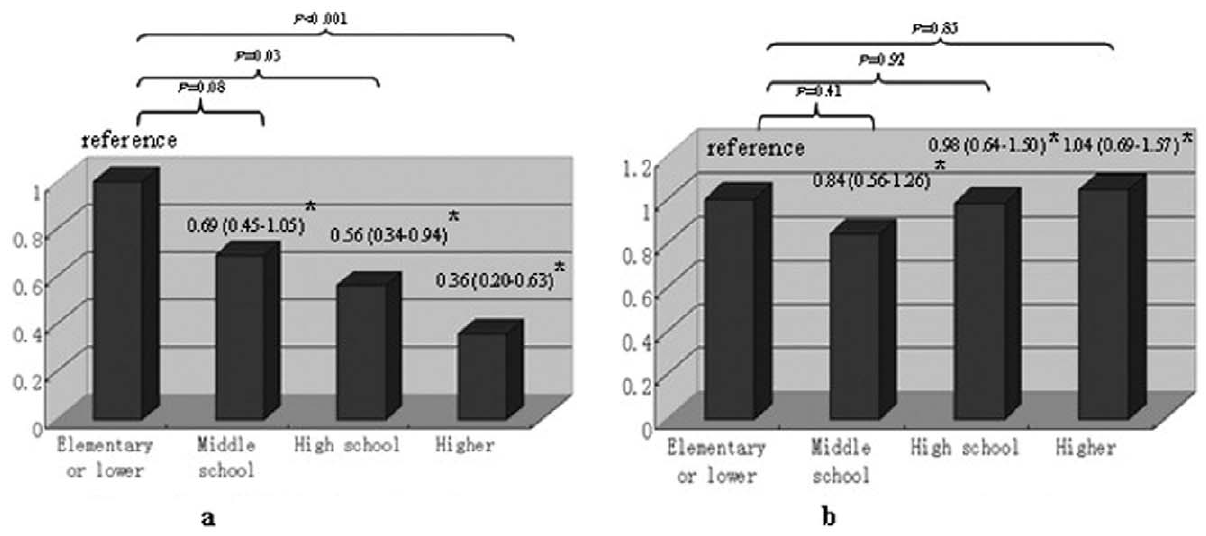
Figure 1. Subgroup analysis of predicted role of education level in all-cause death according to regional economic status. *Adjusted hazard ratio with 95% confidence interval (adjusted for confounders such as age, gender, body mass index, diabetes, cardiovascular disease, hemoglobin, serum albumin, and residual renal function, and stratified by center size) **Undeveloped region: gross domestic product (GDP) per capita , ¥95,000 ($15,009); developed region: GDP per capita $ ¥95,000 ($15,009).